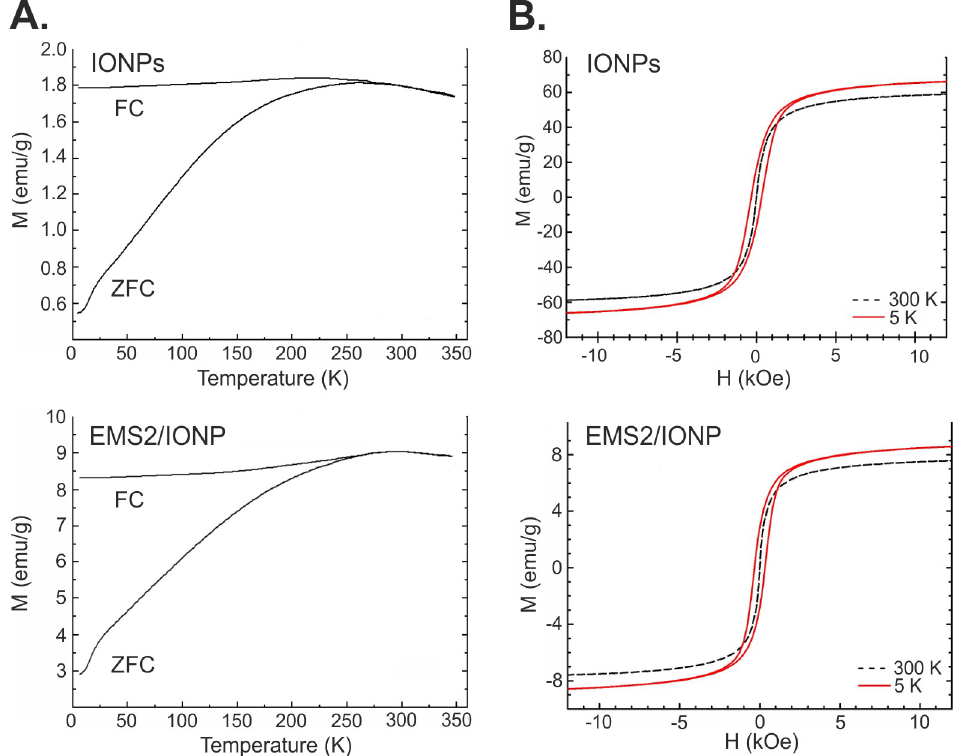
Fig 5. Magnetic measurements of the IONPs and silk/ iron oxide spheres (EMS2/IONP). A) Zero-field-cooled (ZFC) and field-cooled (FC) magnetization curves for IONPs (upper) and EMS2/IONP spheres (bottom); B) Hysteresis loops at T = 5 and 300 K for IONPs (upper) and EMS2/IONP (bottom) spheres.